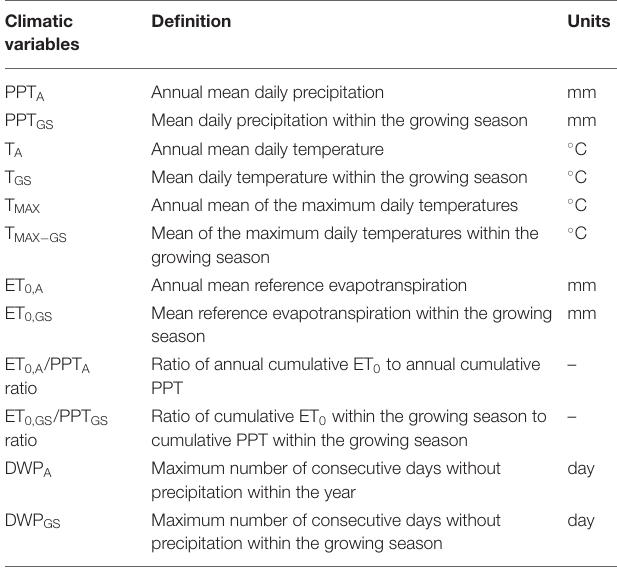
TABLE 1 | Symbols, definitions, and units of the climatic variables considered in this research. Climatic